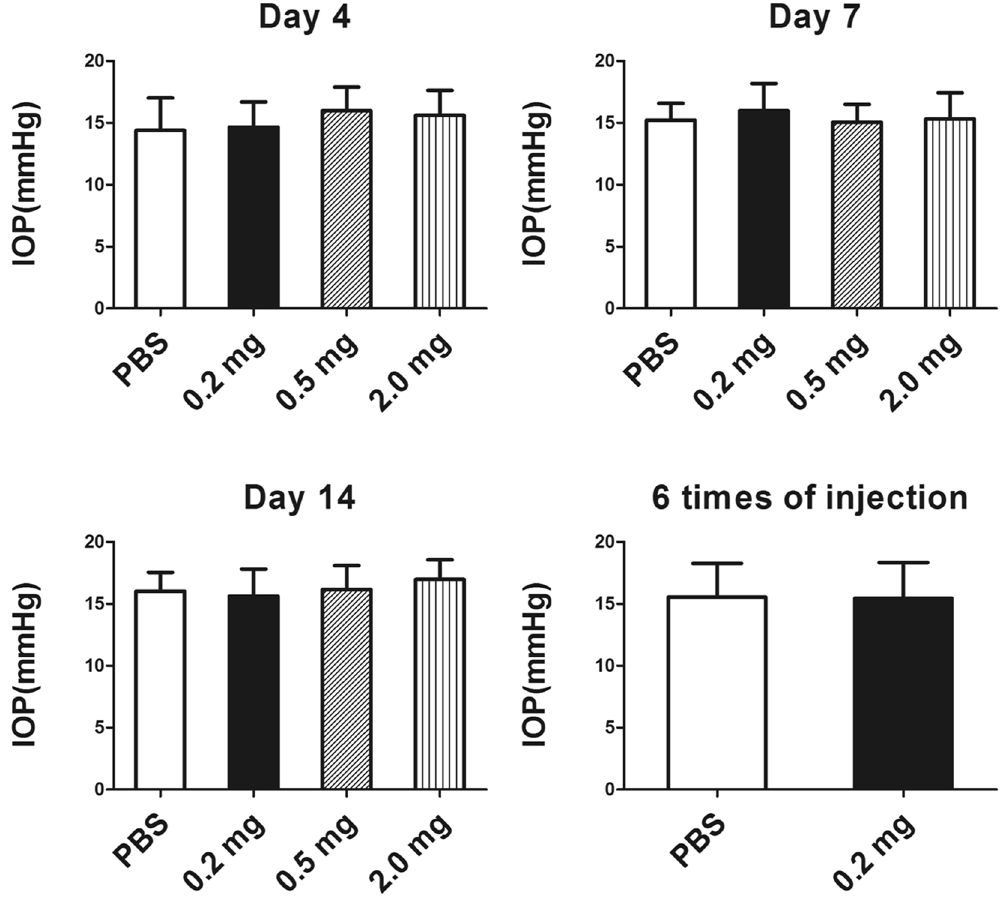
Figure 1. The intraocular pressure (IOP) in rabbits after a single injection of 50 μ L PBS, 0.2, 0.5 or 2.0 mg of conbercept and 6 multiple injections of 50 μ L of PBS or 0.2 mg of conbercept. There was no significance in IOP among the conbercept-injected groups and the PBS-injected groups ( p > 0.05). The results are mean ± SD (n =